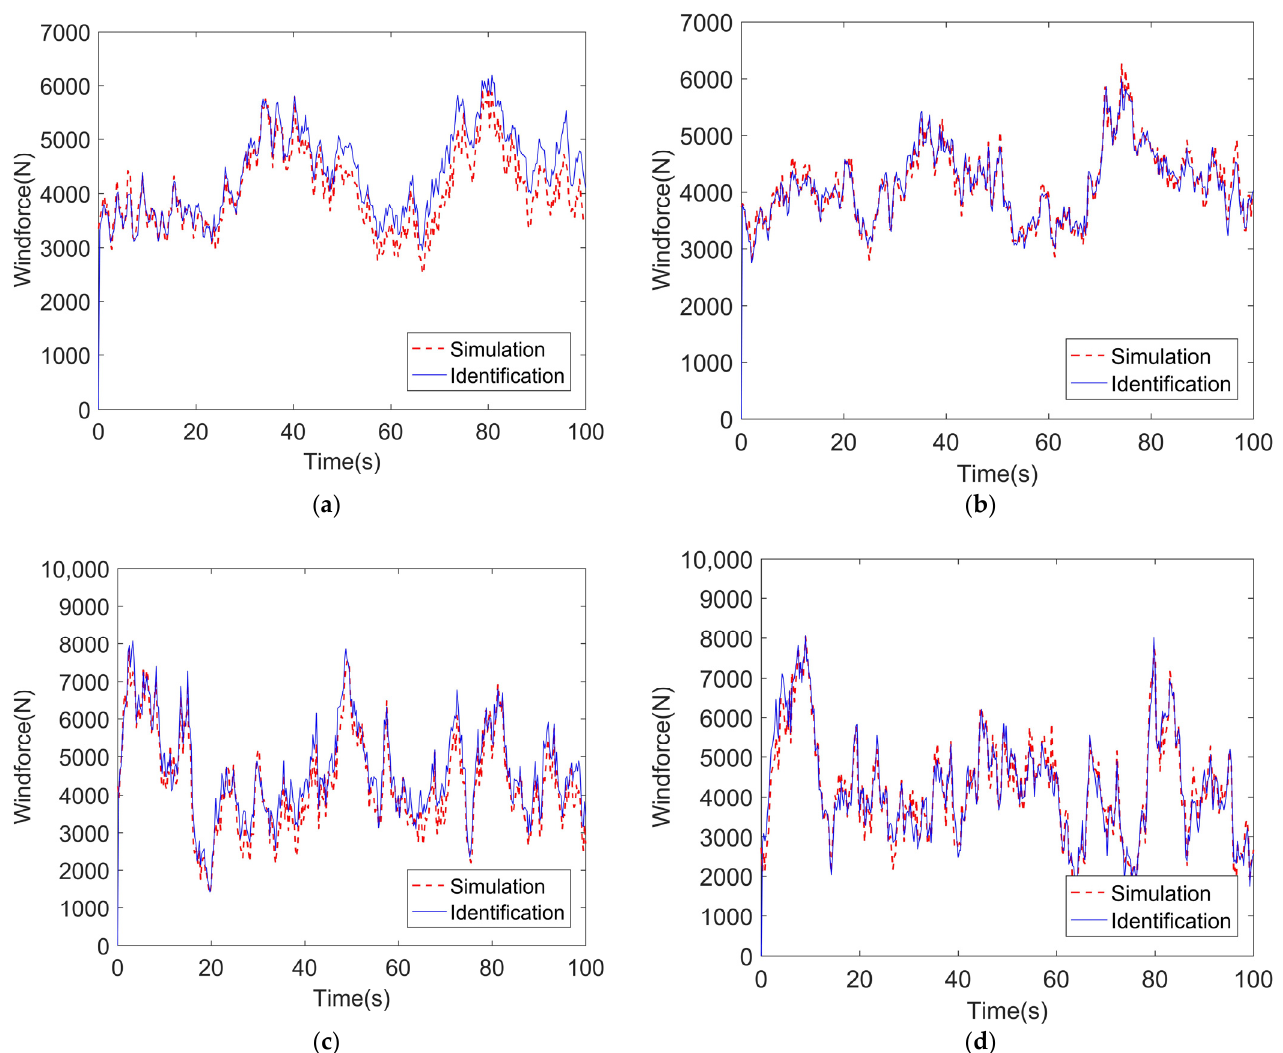
Figure 3. Comparison of time-varying wind loads at ( a ) 5 m level, ( b ) 20 m level, ( c ) 40 m level and ( d ) 60 m level.